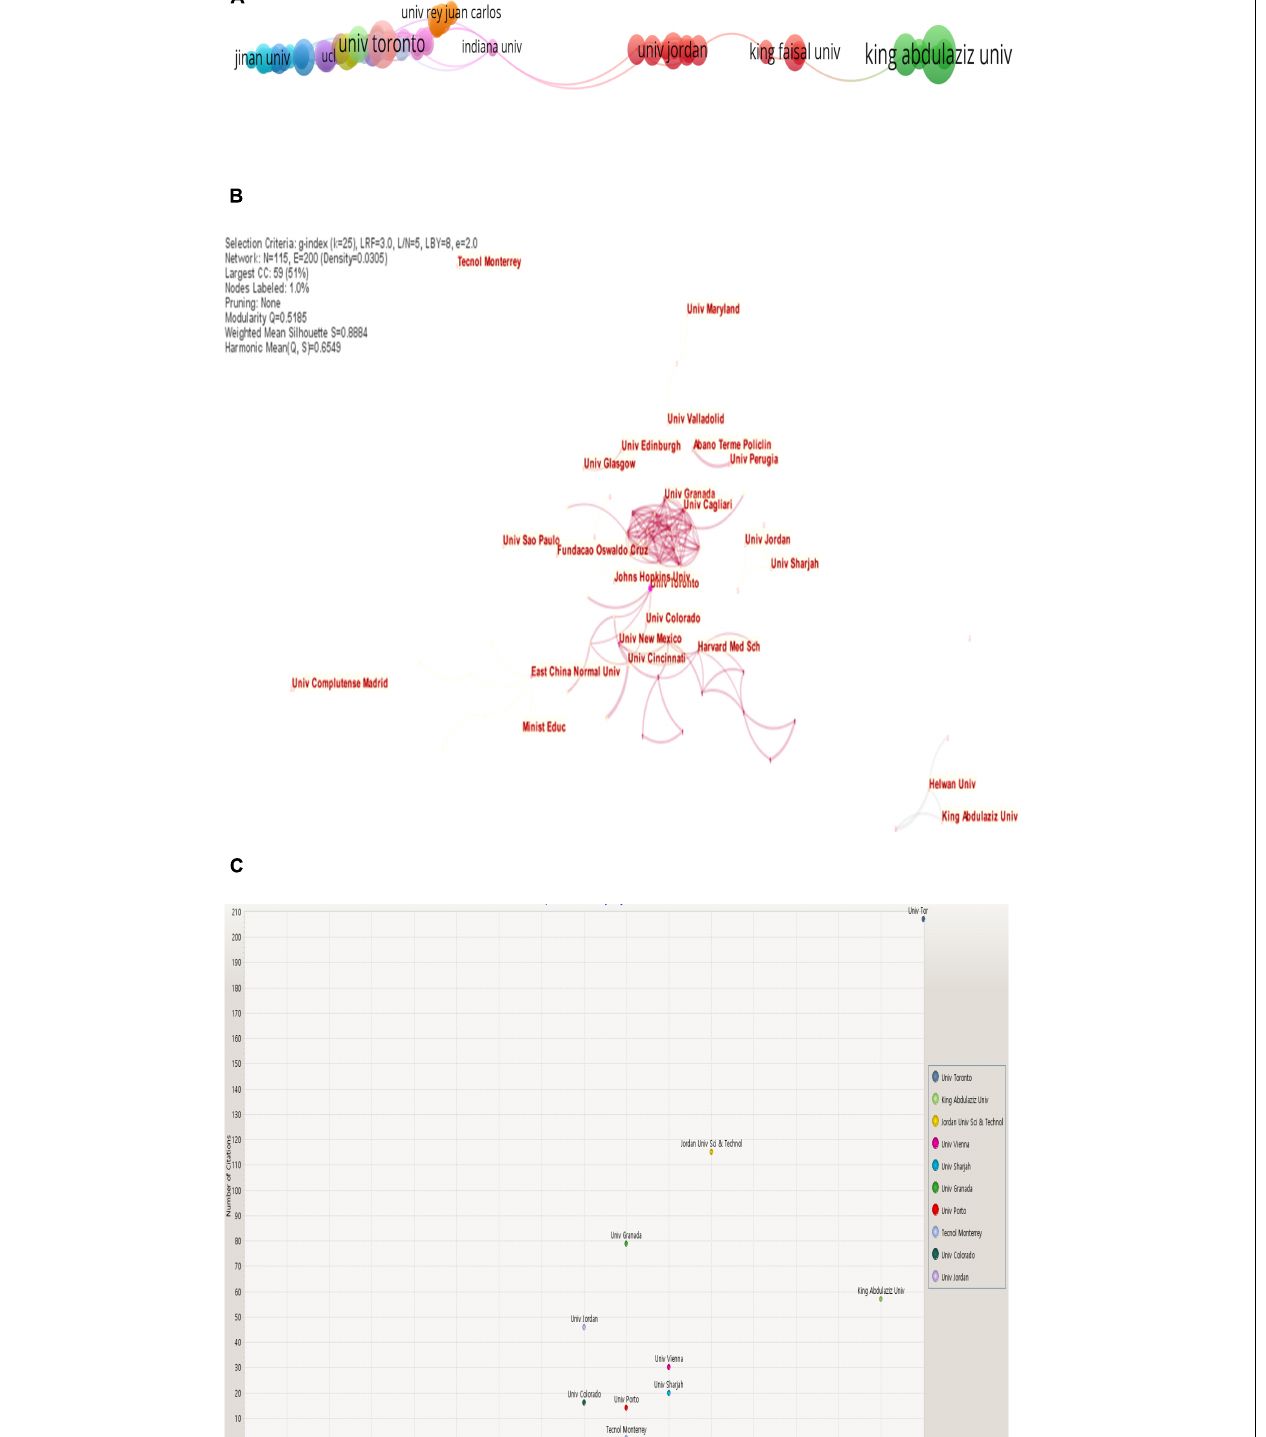
Frontiers in Psychology |